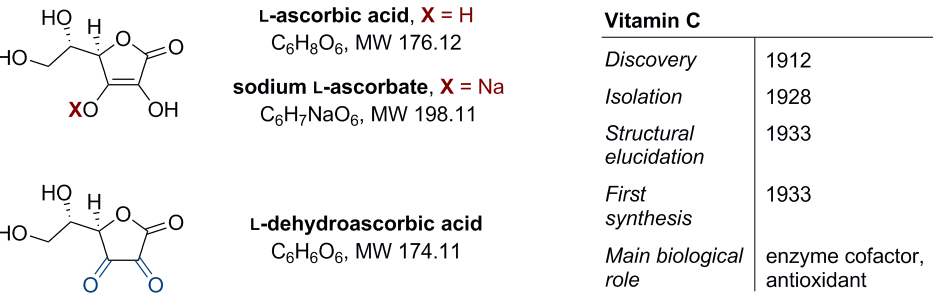
Figure 1. Structure of vitamin C ( L -ascorbic acid, ascorbate), its sodium salt (sodium L -ascorbate), and oxidized form ( L -dehydroascorbic acid) plus additional information on vitamin C [1].